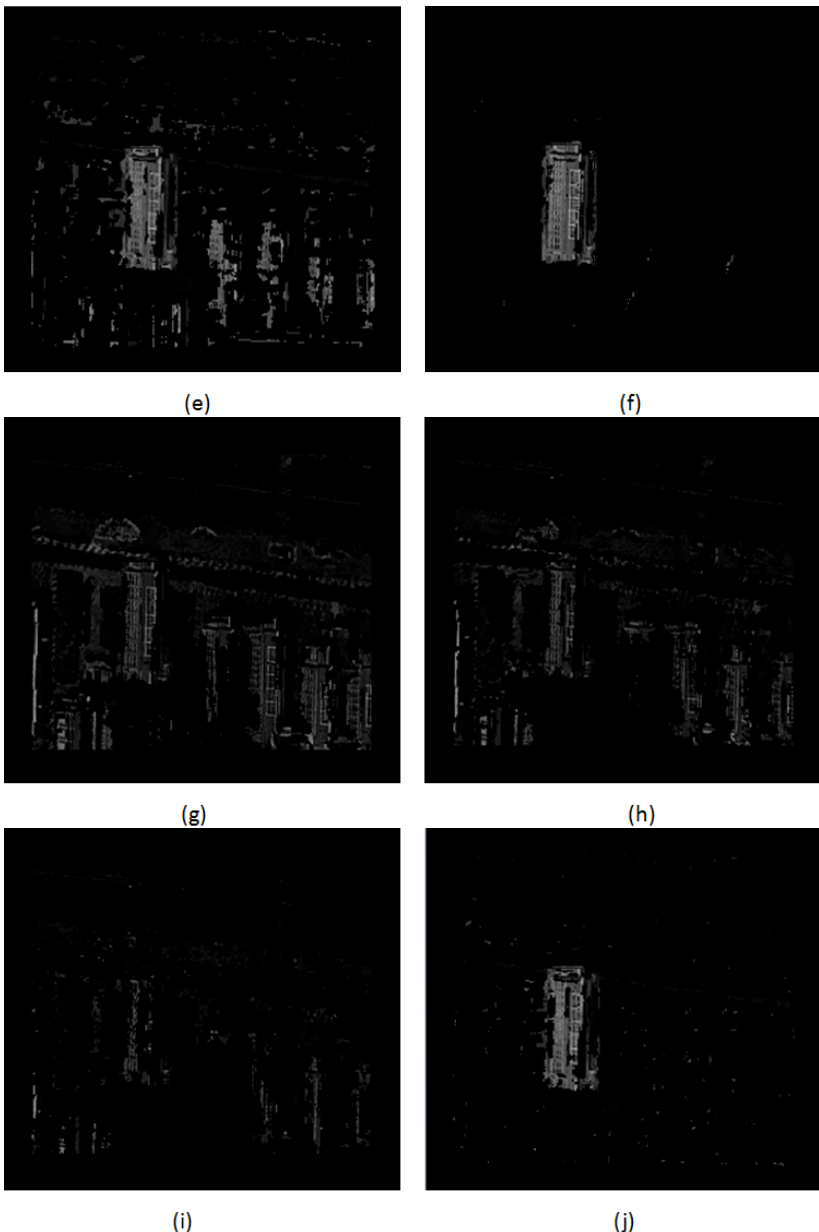
Fig. 10. (a) two third gray value of the sensed image, (b) half gray value of the sensed image, (c), (d), (e) , (f) Reference maps of the changed area of Fig. 10 (a) acquired by square difference, correlation, correlation coefficient and the proposed method, respectively. (g), (h), (i) , (j) Reference maps of the changed area of Fig. 10 (b) acquired by square difference, correlation, correlation coefficient and the proposed method,